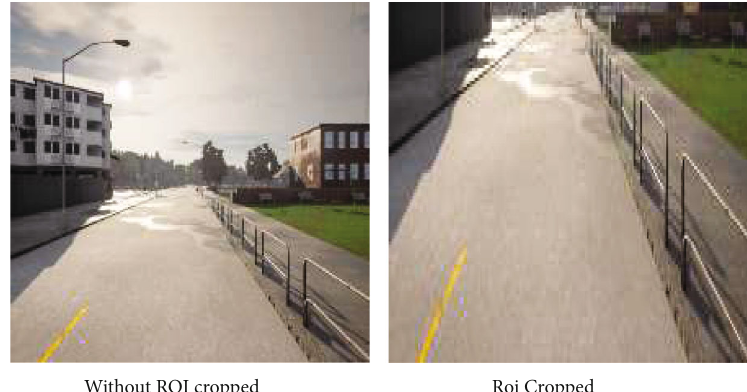
Figure 6: Cropping region of